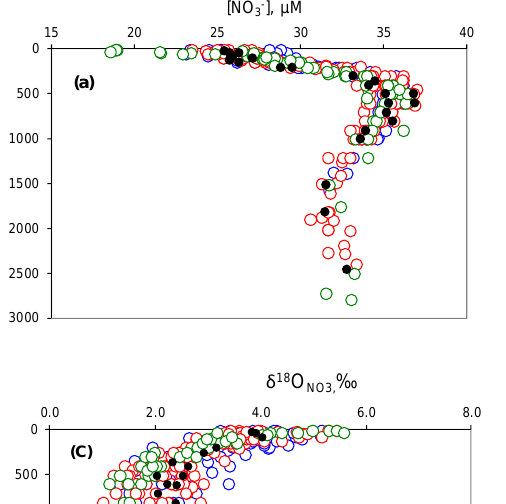
(µM); (b) δ 15 N NO ; (c) δ 18 O NO , and (d) (cid:49) (15–18); Complete data set. Blue circles: Plateau 3 3 3